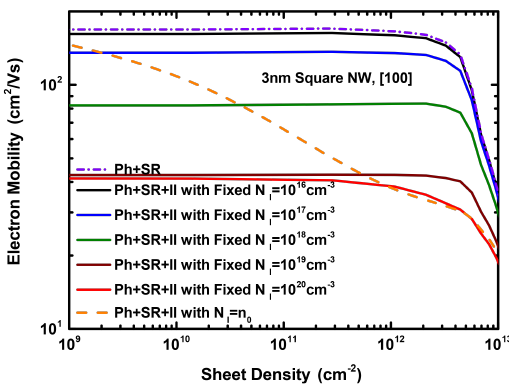
Figure 5. The electron mobility as a function of the sheet density considering the combined total phonon and surface roughness (Ph + SR) scattering rates, as well as the total scattering (Ph + SR + II). The results are for different fixed ionized impurity densities and the charge neutrality case, for a 3 nm diameter square NW with a [100] channel orientation.